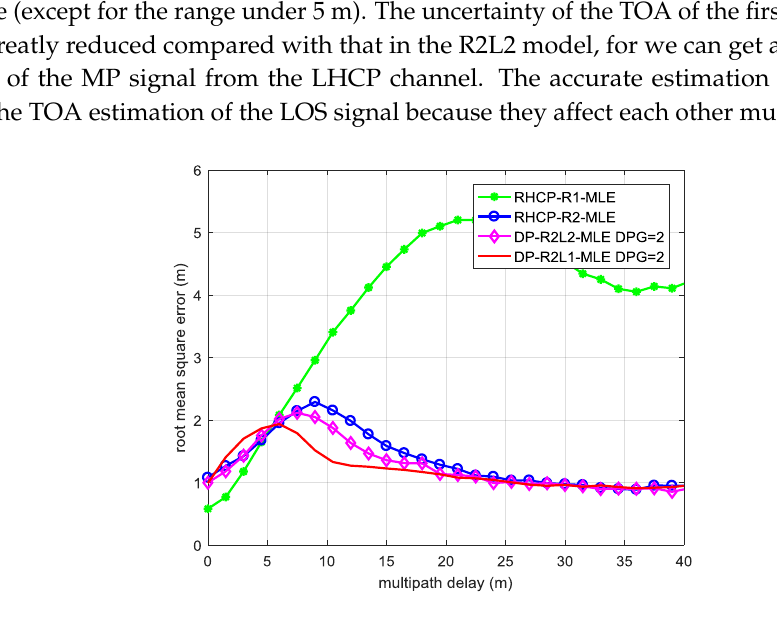
Figure 4. The RMSE of the TOA estimation of LOS signal using MLE with different signal models in the two-path environments defined by Strong LHCP Signal Case 1 in Table 2.